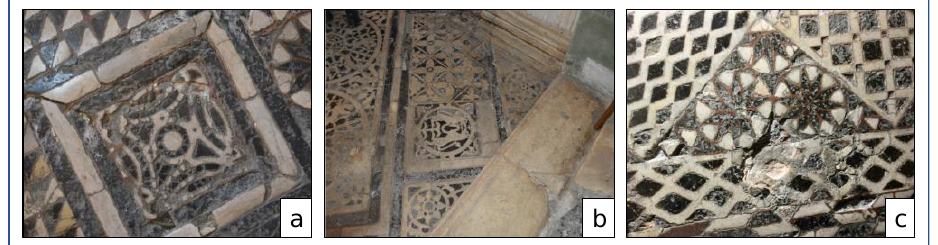
Figure 4. Fracture ( a , b ), loss of material ( a – c ), discolouration ( b ), differential erosion ( a , c ), lacunae ( c